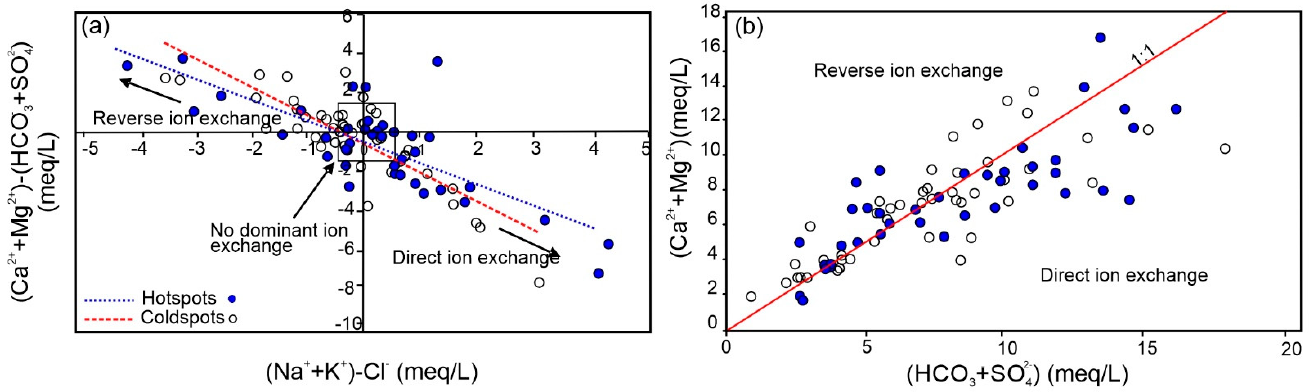
Figure 5. Scatter plots indicating the presence of ion-exchange process in groundwater: ( a ) (Ca 2+ + Mg 2+ ) − (HCO 3 − + SO 42 − ) vs. (Na + + K + ) − Cl − ; ( b ) (Ca 2+ + Mg 2+ ) vs. (HCO 3 − + SO 42 − ).